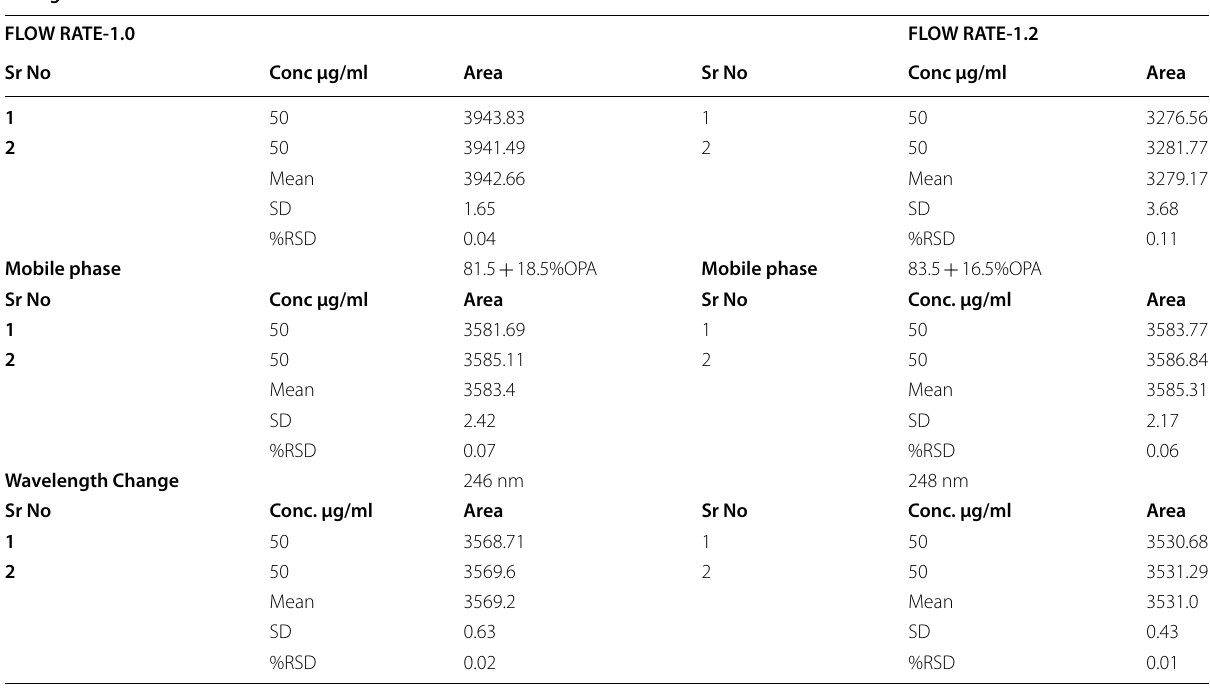
Table 10 Robustness study